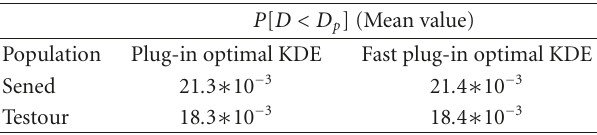
Table 6: Mean values of P [ D < D p ] obtained from the two optimal plug-in KDE